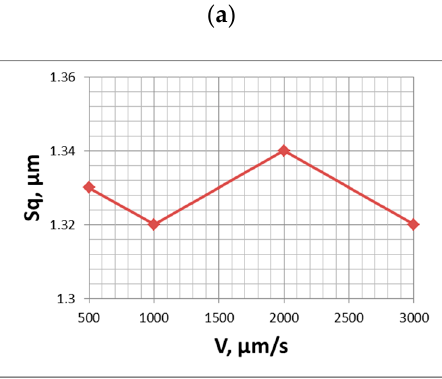
Figure 3. Influence of stylus speed on the values of parameters Sq ( a ) and Sdq ( b ) of the plateau-honed surface topography, adapted from [29].